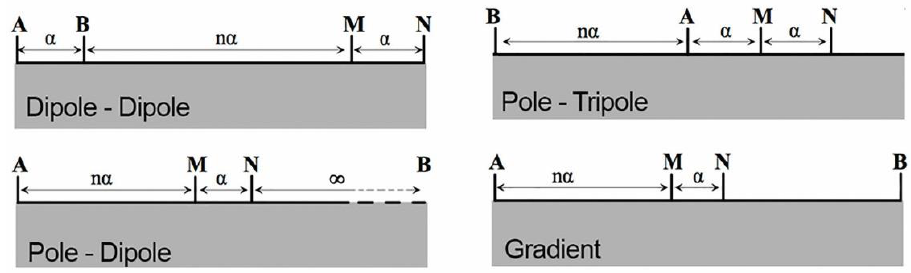
Figure 2. Representation of the basic arrays used to generate the comprehensive data set.